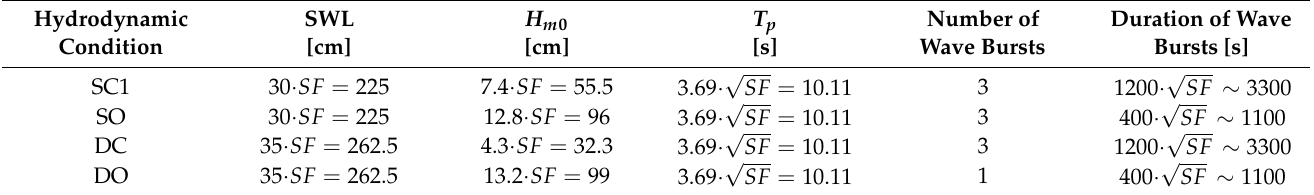
Table 1. Upscaled (hydrodynamic) boundary conditions according to Froude with still water level above the flume ground (SWL), zero-moment wave height H m0 , peak wave period T p and the number and durations of wave bursts. The latter two define the applied simulation times ( tstop ).